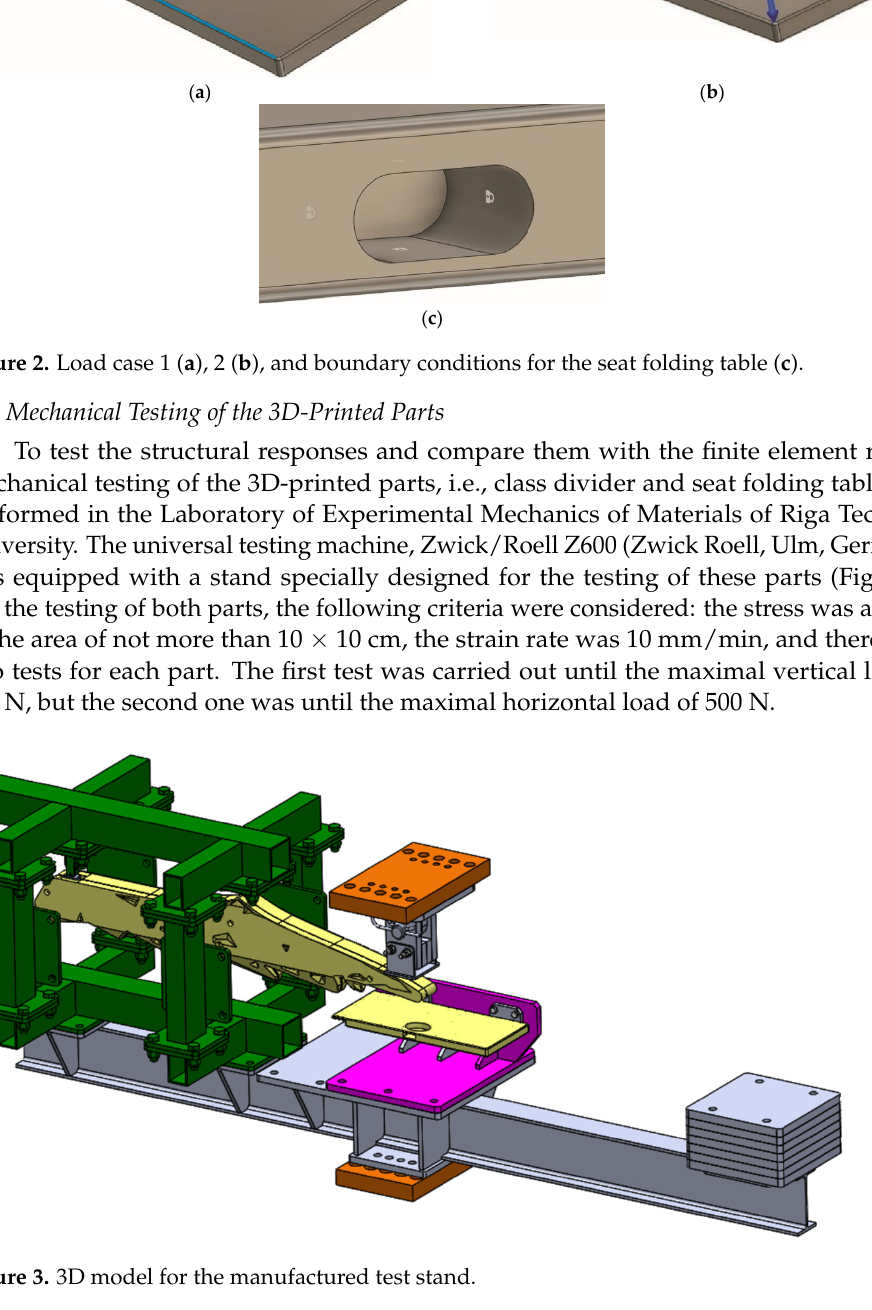
( b ) Figure 4. Class-divider part: ( a ) assembled, and ( b ) inside view of the two halves of the class di- vider. Figure 4 shows the assembled class divider and the inside structure of the two CNC metal halves, when separated. Two metal parts and simulating loads were analyzed as they would be manufactured from Ultem 9085 material with small design adjustments to compensate for the switch from the metal to the polymer. Judging from the part’s slender shape and long moment arm, it is reasonable to ex- pect that the top right or bottom left load cases would be the most difficult to meet. This suggests that initial design changes should focus on the structure’s bending stiffness around the z -axis. For a simple cantilever beam loaded at the tip, the expression for its bending stiffness, K , is: